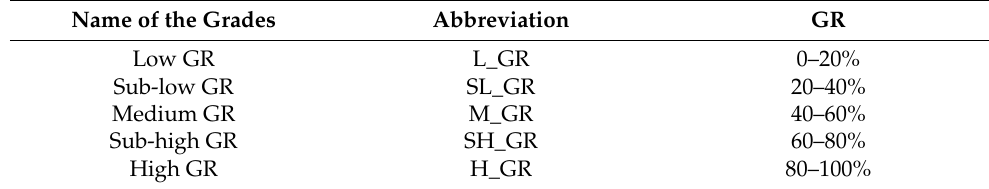
Table 3. The grades of GR.